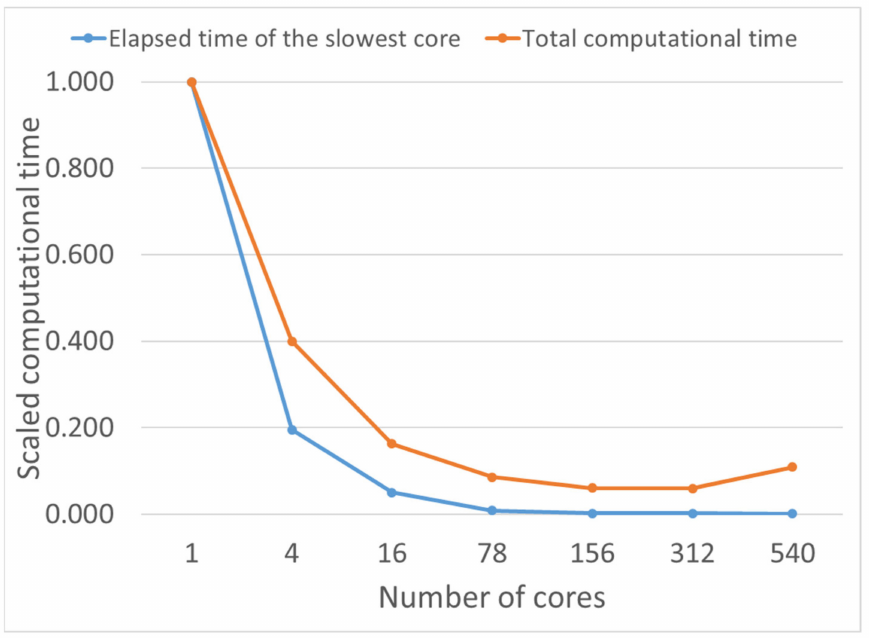
Figure 6. Comparison of elapsed (clock) time of the slowest core and total computational time using task farming; note that the horizontal axis scale is